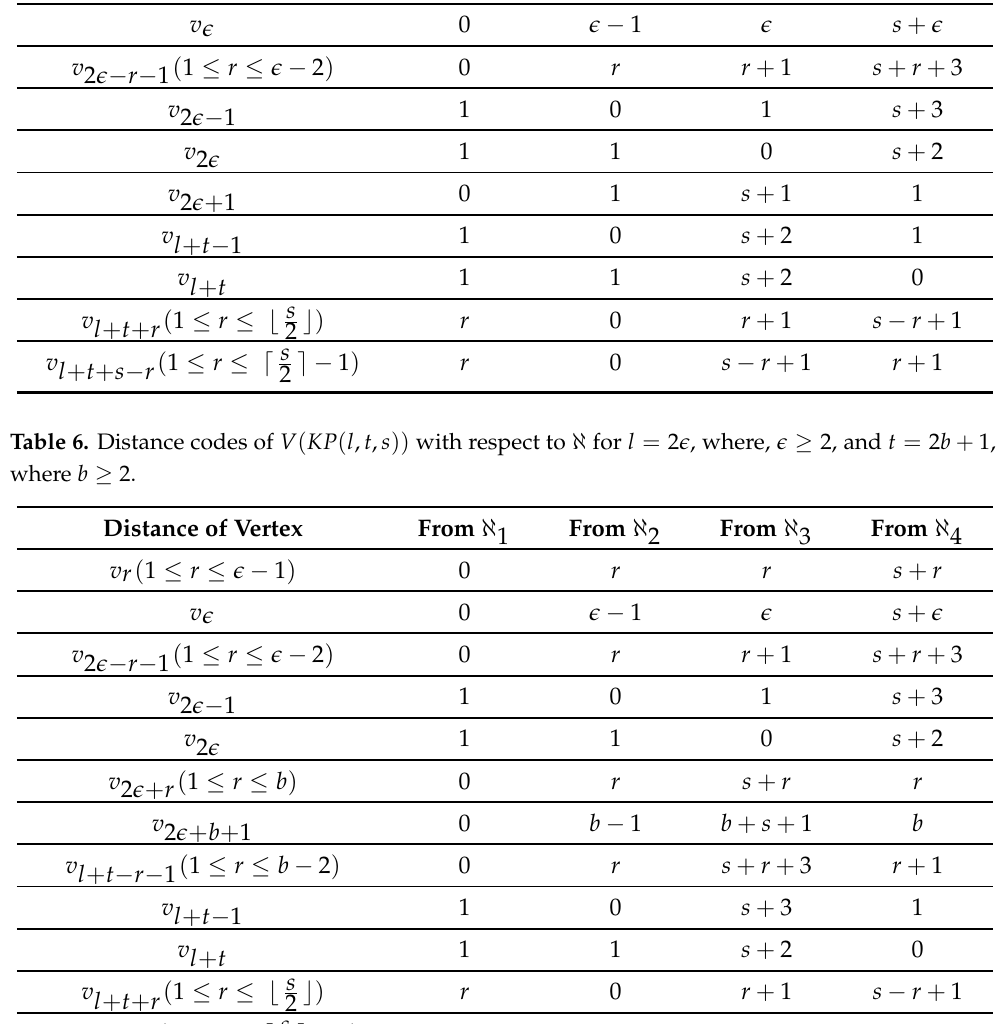
Table 5. Distance codes of V ( KP ( l , t , s )) with respect to ℵ for l = 2 (cid:101) , where, (cid:101) ≥ 2, and t = 3. Distance of Vertex From ℵ 1 From ℵ 2 From ℵ 3 From ℵ 4